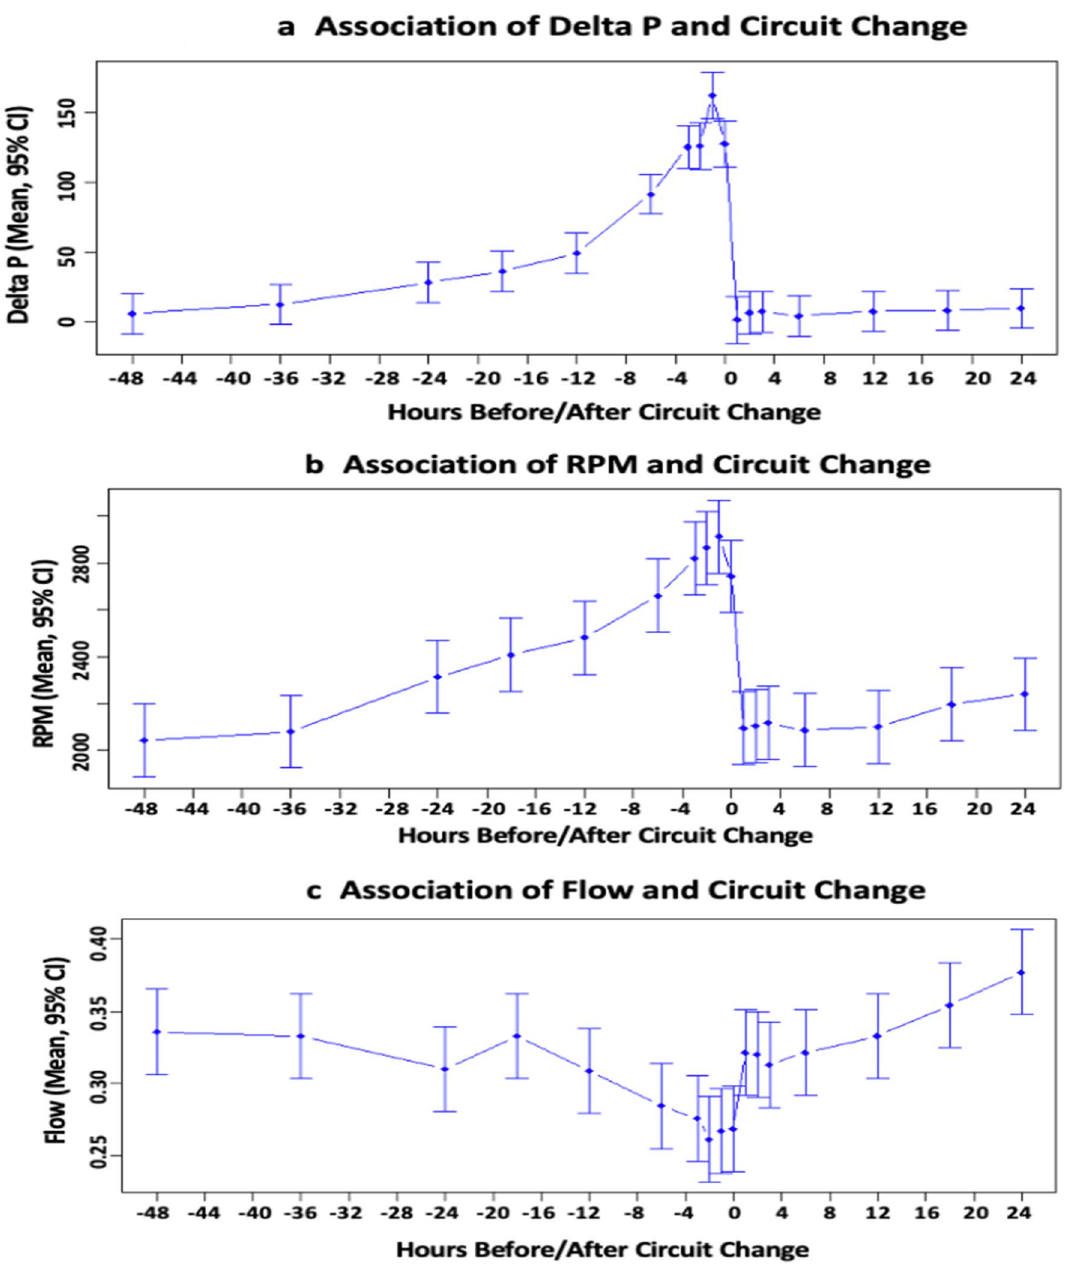
Figure 1. Associations of circuit parameters with circuit change. ECMO circuit mean and SD parameter changes over time before impairment (change) of circuit at 0 h of time and 24 h post circuit change. ( a ) Circuit Delta-P mean and SD values over time (p < 0.011 and < 0.012 respectively), ( b ) Circuit RPM mean and SD values (p < 0.004 and p < 0.005 respectively), ( c ) Circuit Flow mean and SD values (p < 0.0001). RPM Revolutions per minute, SD Standard